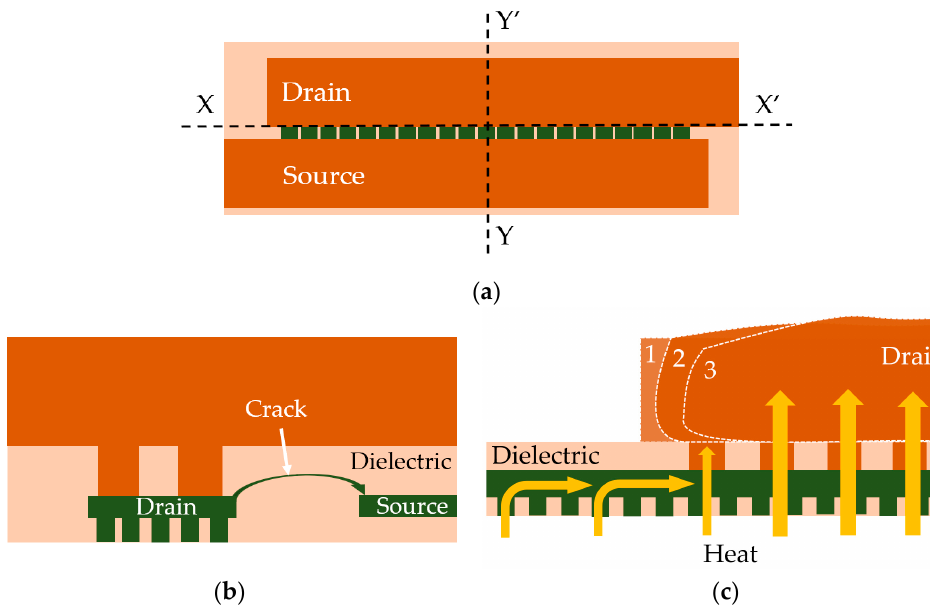
Figure 2. ( a ) Top view of the DMOS device metallization; ( b ) cross section alongside XX’ axis, illustrating the IMD cracking; ( c ) cross section alongside YY’ axis illustrating the PM delamination.